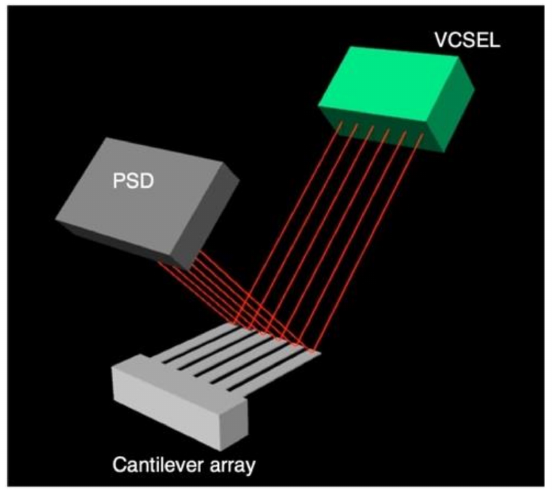
Figure 8. A typical setup for the optical (laser) readout system. VCSEL is usually used as a source of multiple laser light. Each laser light reflected on the surface of each cantilever is measured by